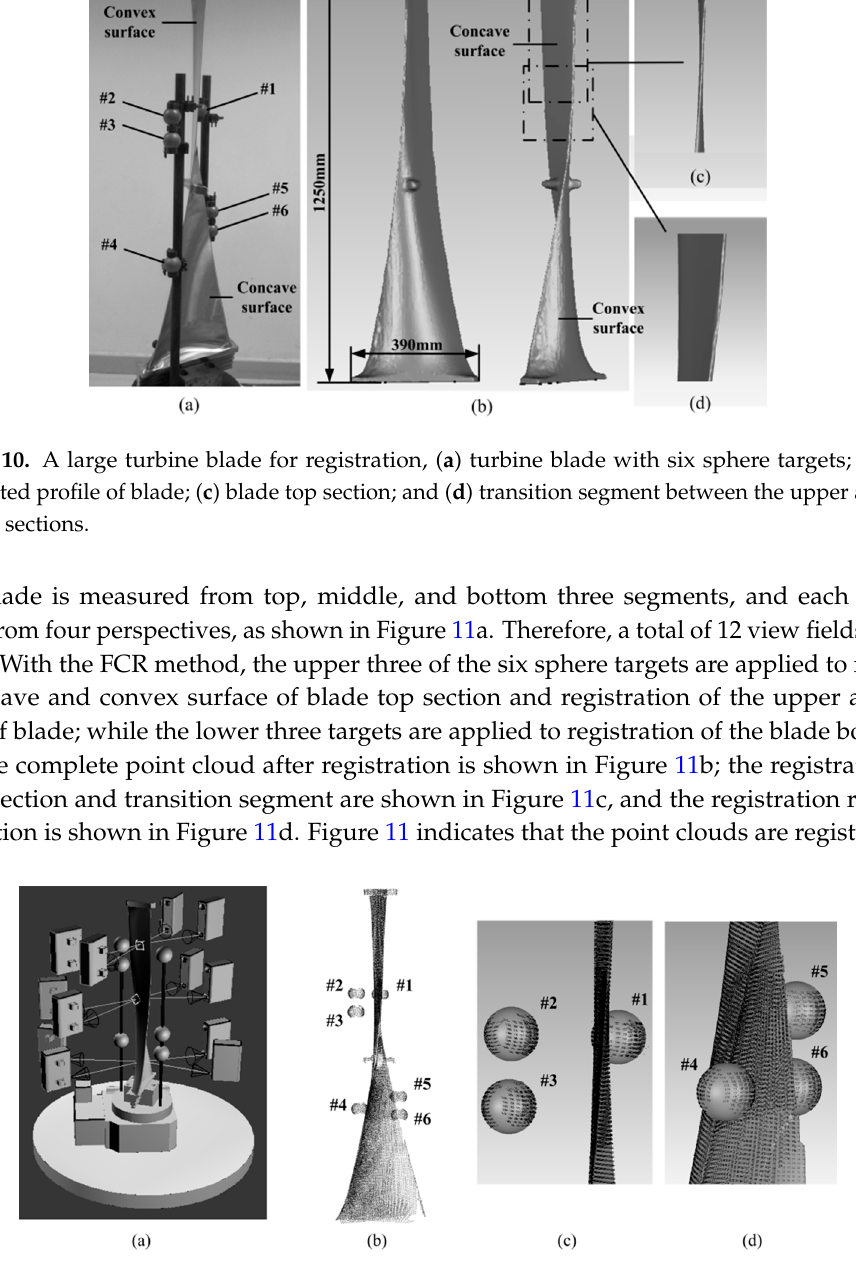
Figure 12. Radius deviation of the six sphere targets with FCR and SCR, respectively. Overall, the FCR method solves the problems of imprecise registration with non-overlapping areas or curvature invariant surface. Theoretically, its precision is not limited by the measured object size, and by only adding some feature targets, it is convenient to achieve a high-precision registration. 5. Conclusions The paper proposes a sphere Feature Constraint Registration method (FCR), which is adapted for high-precision registration of the multi-view point clouds with non-overlapping areas or curvature invariant surface. The proposed method introduces some known sphere features to construct virtual overlapping areas for registration with non-overlapping areas point clouds, and utilizes the feature constraint to reduce the impact of the noise in point clouds and prevent the solution from falling into a local optimum. Even for the point clouds with overlapping areas, the proposed method is more accurate, since the corresponding points are selected from a continuous and ideal surface instead of the actual discrete measured points. The transformation parameters are solved by the optimization method with weight functions. In that case, the impact of large noise is reduced, and the registration stability is improved. Simulation and experiment results indicate that